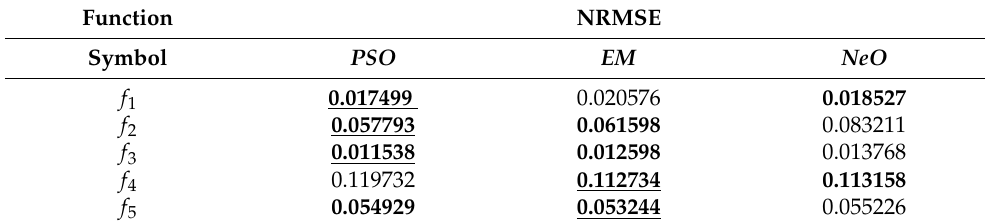
Table 2. Training error.